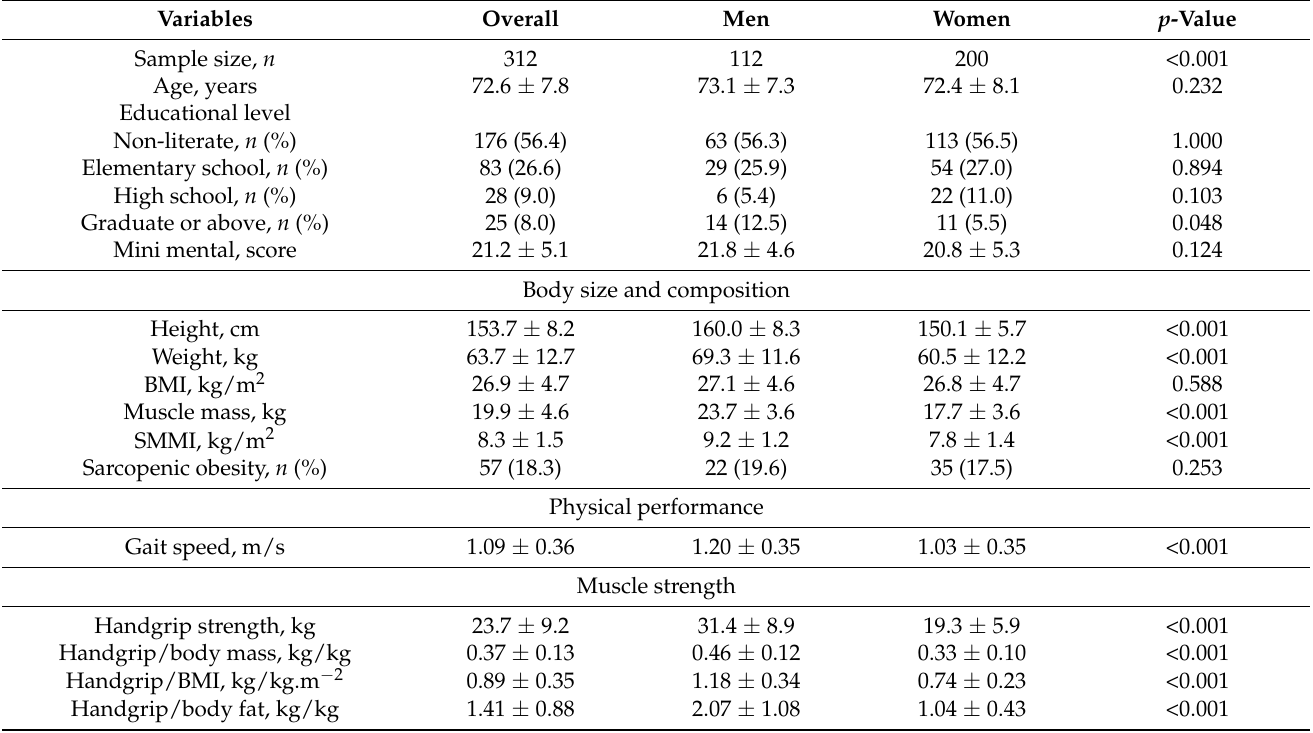
Table 1. Characteristics of the participants.